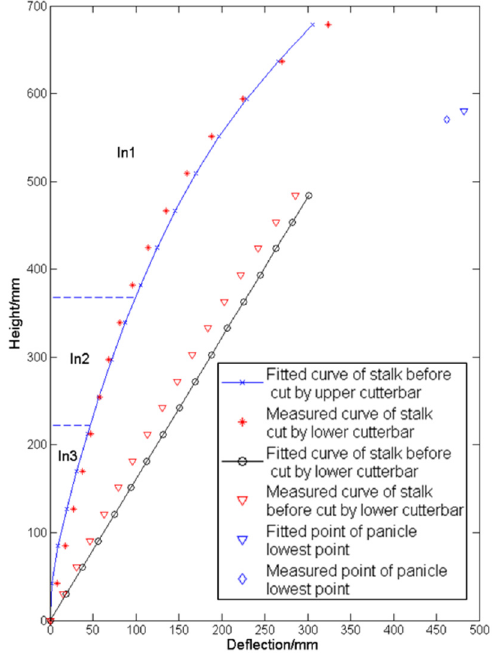
Figure 7. The contrast of fitted and measured rice plant.